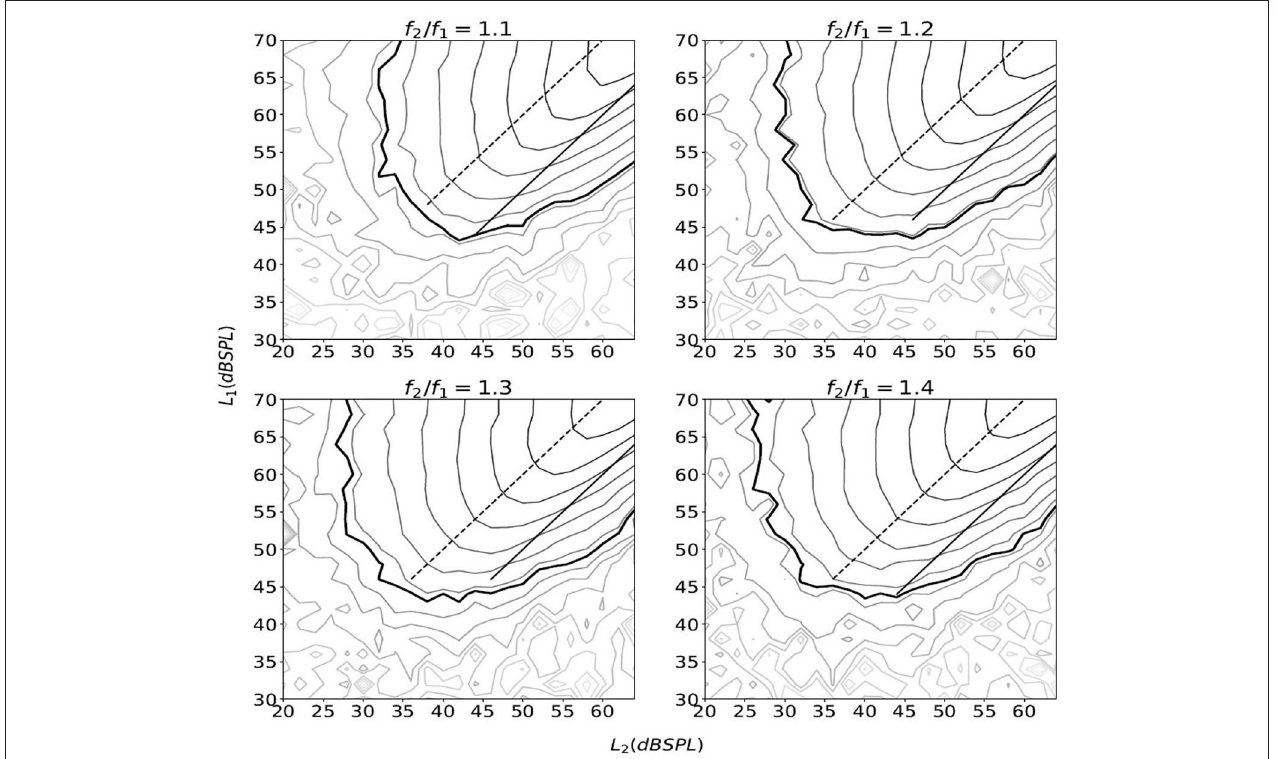
FIGURE 2 | The equal-level contour plots of IMD3 as a function of ( L 1 , L 2 ). The thick line marks L IMD3 = 0 dB SPL, and other lines are in 4-dB steps. The IMD3 level were obtained by varying L 1 from 30 to 70 dB SPL and L 2 from 20 to 64 dB SPL in 2 dB steps. For each combination of ( L 1 , L 2 ), the stimulus lasted for 1.0 s with a 2.5-ms raised cosine ramp for the rising and falling edges. The stimulation was repeated five times and the average IMD3 level is shown. The solid line and the dashed line represent L 1 = L 2 and L 1 = L 2 + 10 (dB),